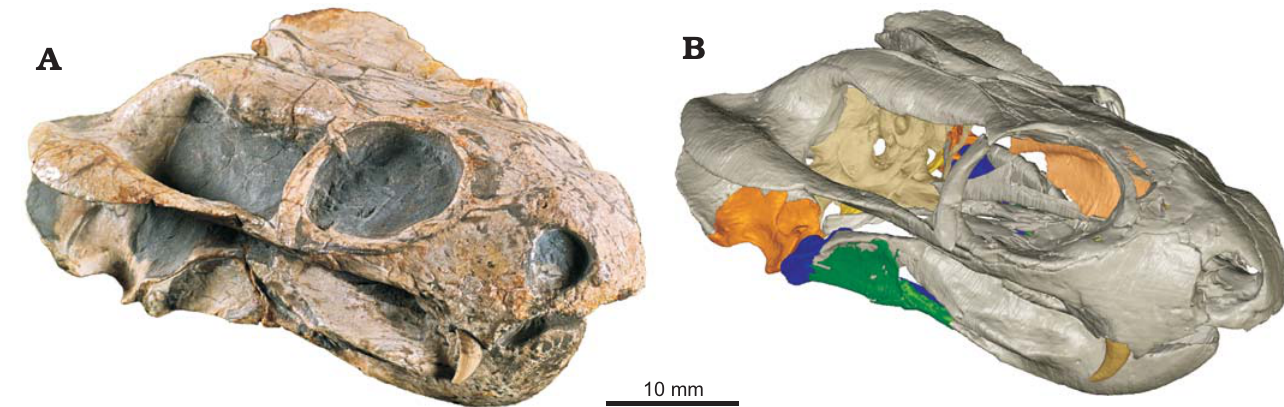
Fig. 1. The skull of the non-mammalian synapsid Pristerodon mackayi Huxley, 1868 (MB.R.985) from the Late Permian of Biesjespoort, South Africa. Photograph ( A ) and virtual 3D model ( B ) of dorsolateral